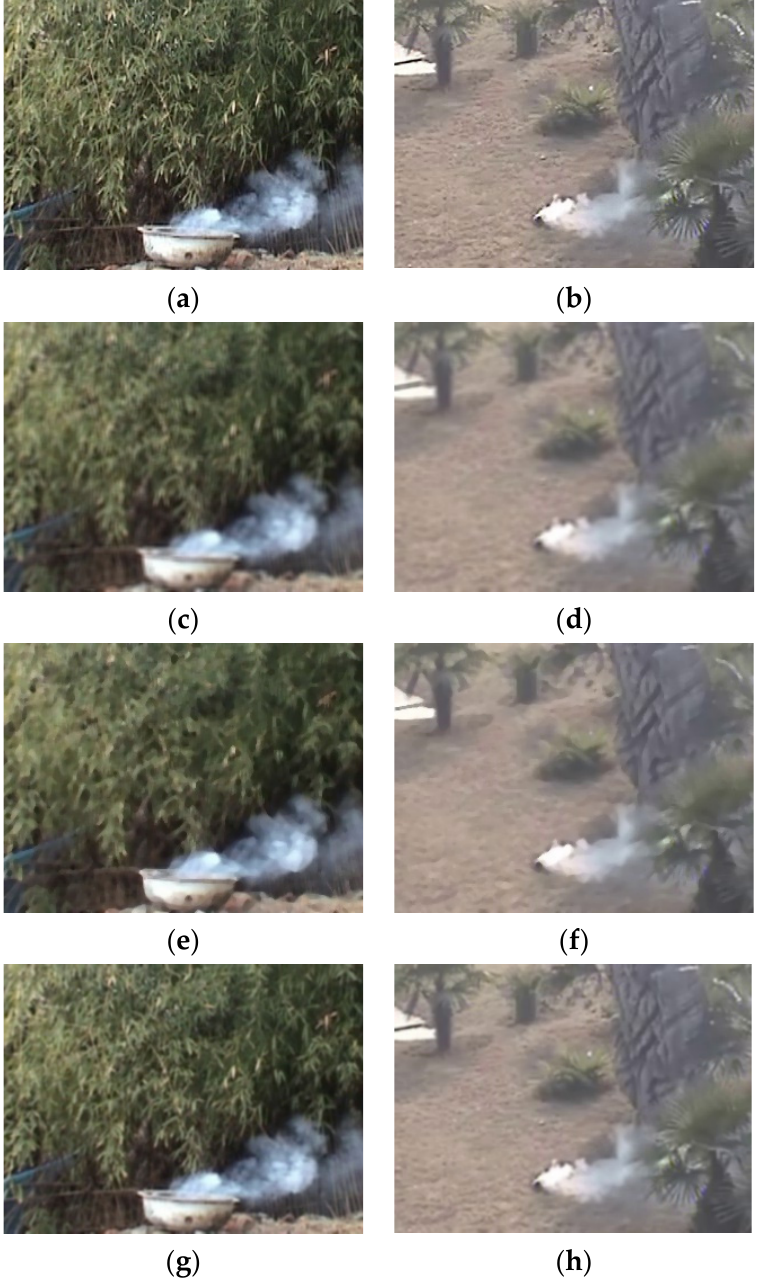
Figure 4. Example of filtering effect: ( a , b ): original image; ( c , d ): mean filtering; ( e , f ): median filtering; ( g , h ): Gaussian filtering.